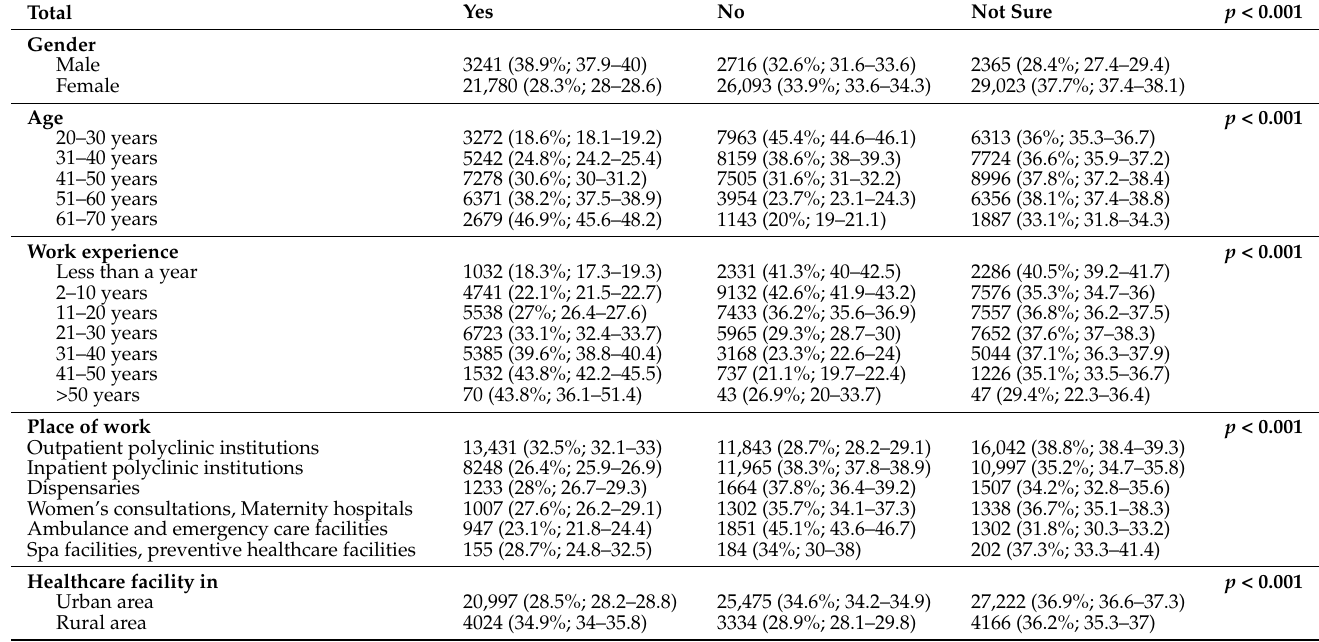
Table A3. Question: “Are you ready to recommend vaccination against COVID-19?”—absolute value, proportion and 95% confidence